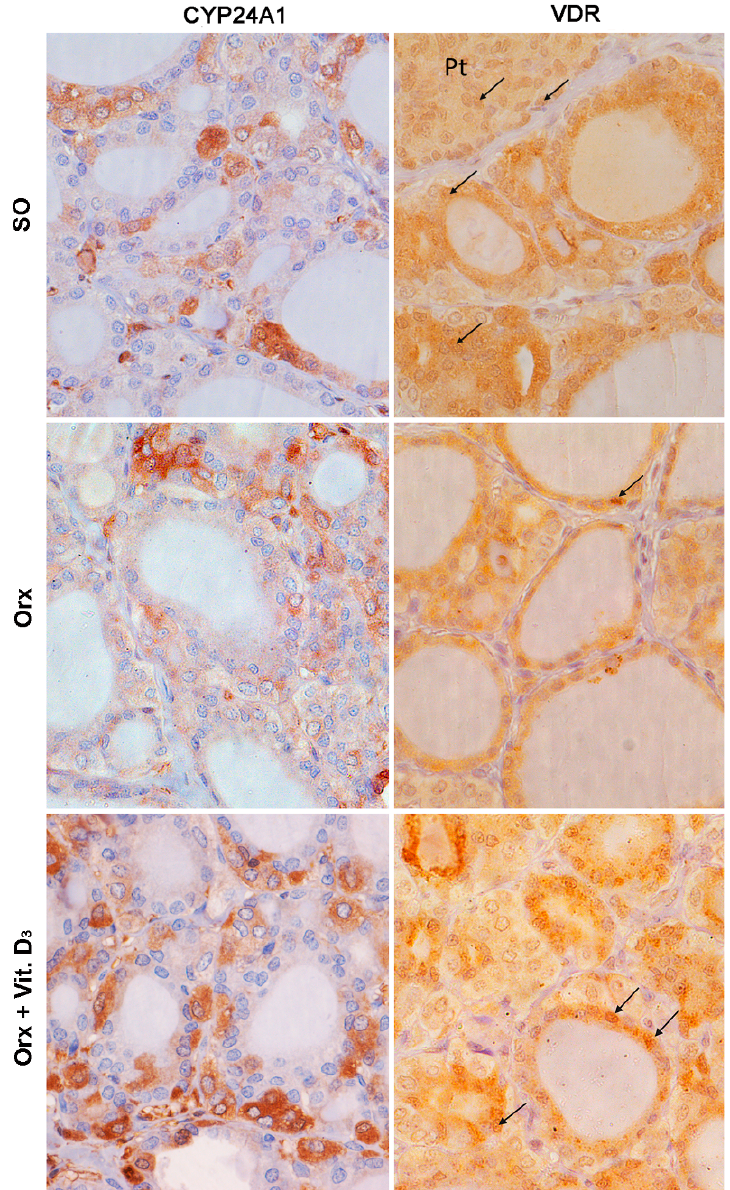
Figure 5. Representative micrographs of immunohistochemical staining showing localization of 24- hydroxylase (CYP24A1) and vitamin D receptor (VDR; arrows point to VDR-immunopositive nuclei) in the thyroid of sham-operated (SO), orchidectomized (Orx), and orchidectomized cholecalciferol-treated (Orx + Vit. D 3 ) rats. Pt, parathyroid gland.